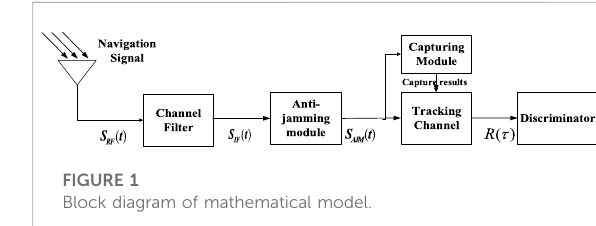
FIGURE 1 Block diagram of mathematical